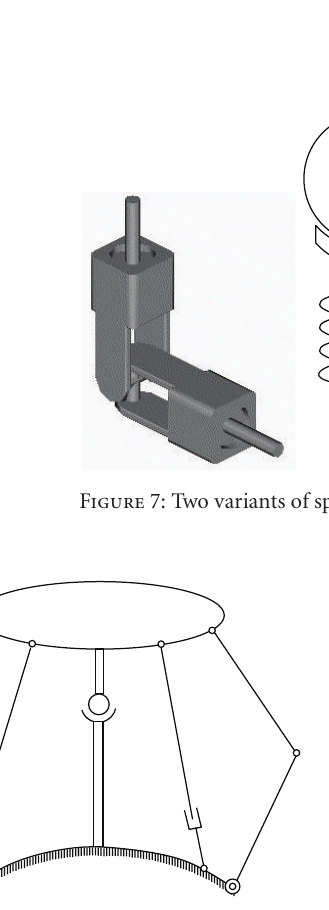
Figure 8: Di ff erent kinds of strut actuation.